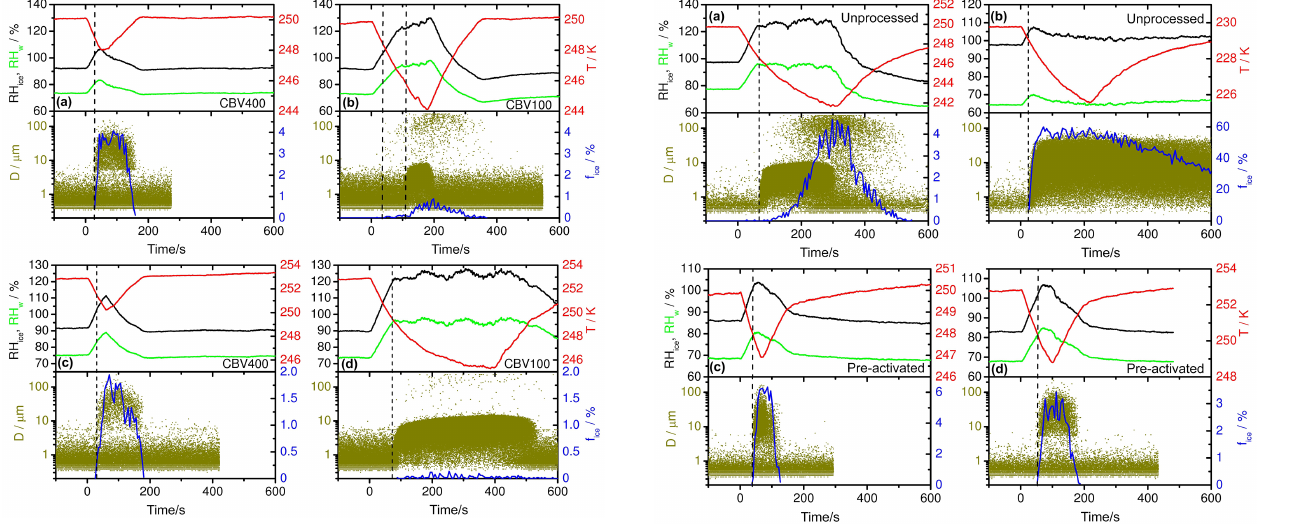
Figure B1. Ice nucleation characteristics of unprocessed (a, b) and pre-activated (c, d) illite NX particles during expansion cooling. The data types are the same as shown in Fig.